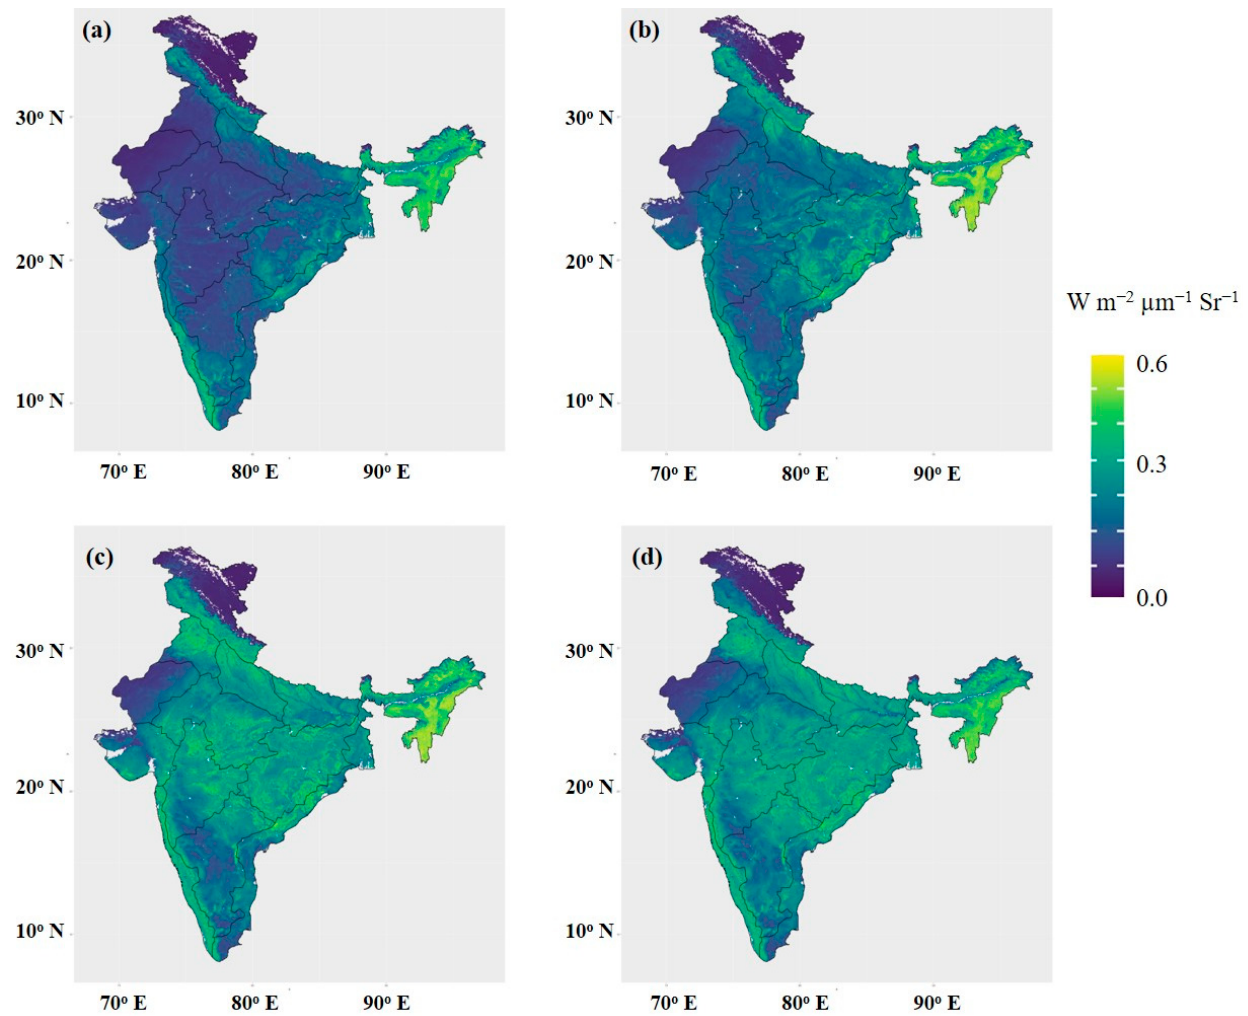
Figure 3. Spatial variation of mean SIF across India during the months of ( a ) June, ( b ) July, ( c ) August and ( d ) September indicates a progressive increase from June to September with respect to the growing season. (Software used: R version 4.0.5 (2021), https://www.R-project.org/ (accessed on 25 July 2021)).